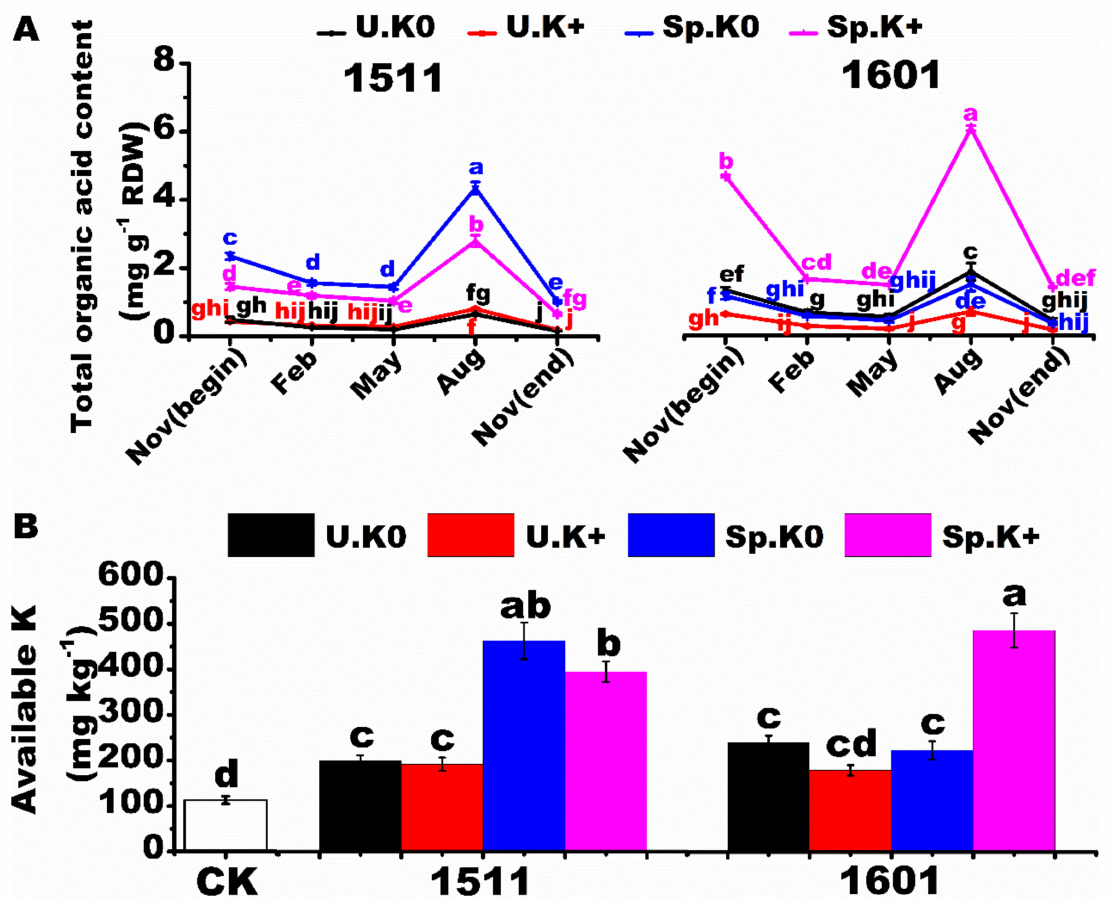
Figure 6. Temporal variations of organic acids in root exudates and solubilization of soil K by root exudates. Temporal variation of total organic acid content of root exudates ( A ). Solubilization of soil K by root exudates ( B ). CK treatment represents the soil without root exudates. U.K0, U.K+, Sp.K0 and Sp.K+ treatments represent the soils with root exudates collected from U.K0, U.K+, Sp.K0 and Sp.K+ treatments in the mini root boxes. The letter colors were consistent with the representative colors of the treatments. Data are means ± SE ( n = 3). Different letters represent significant differences at the level of p <